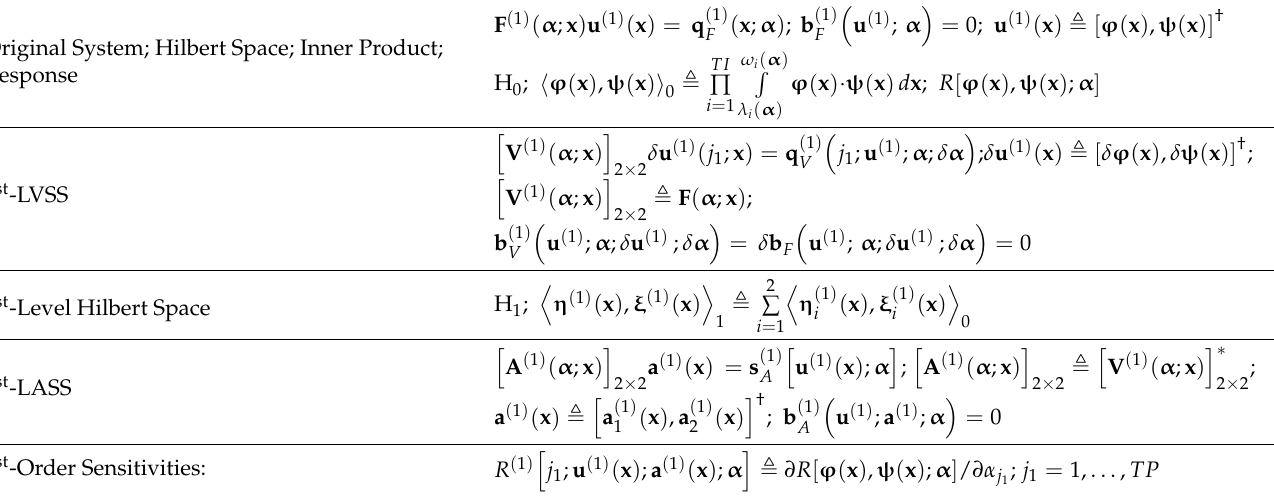
Table 1. First-Order Sensitivities ( n = 1).